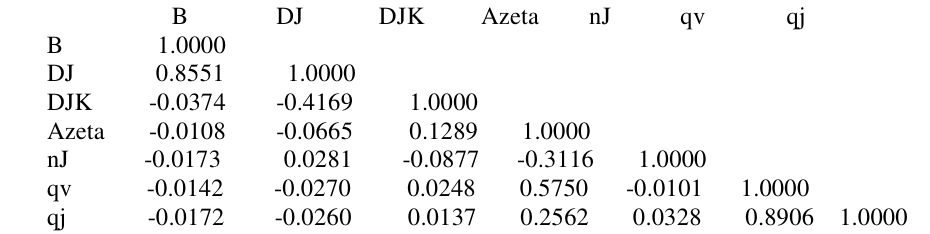
O) in v (E) = 1 and v 2 3 1